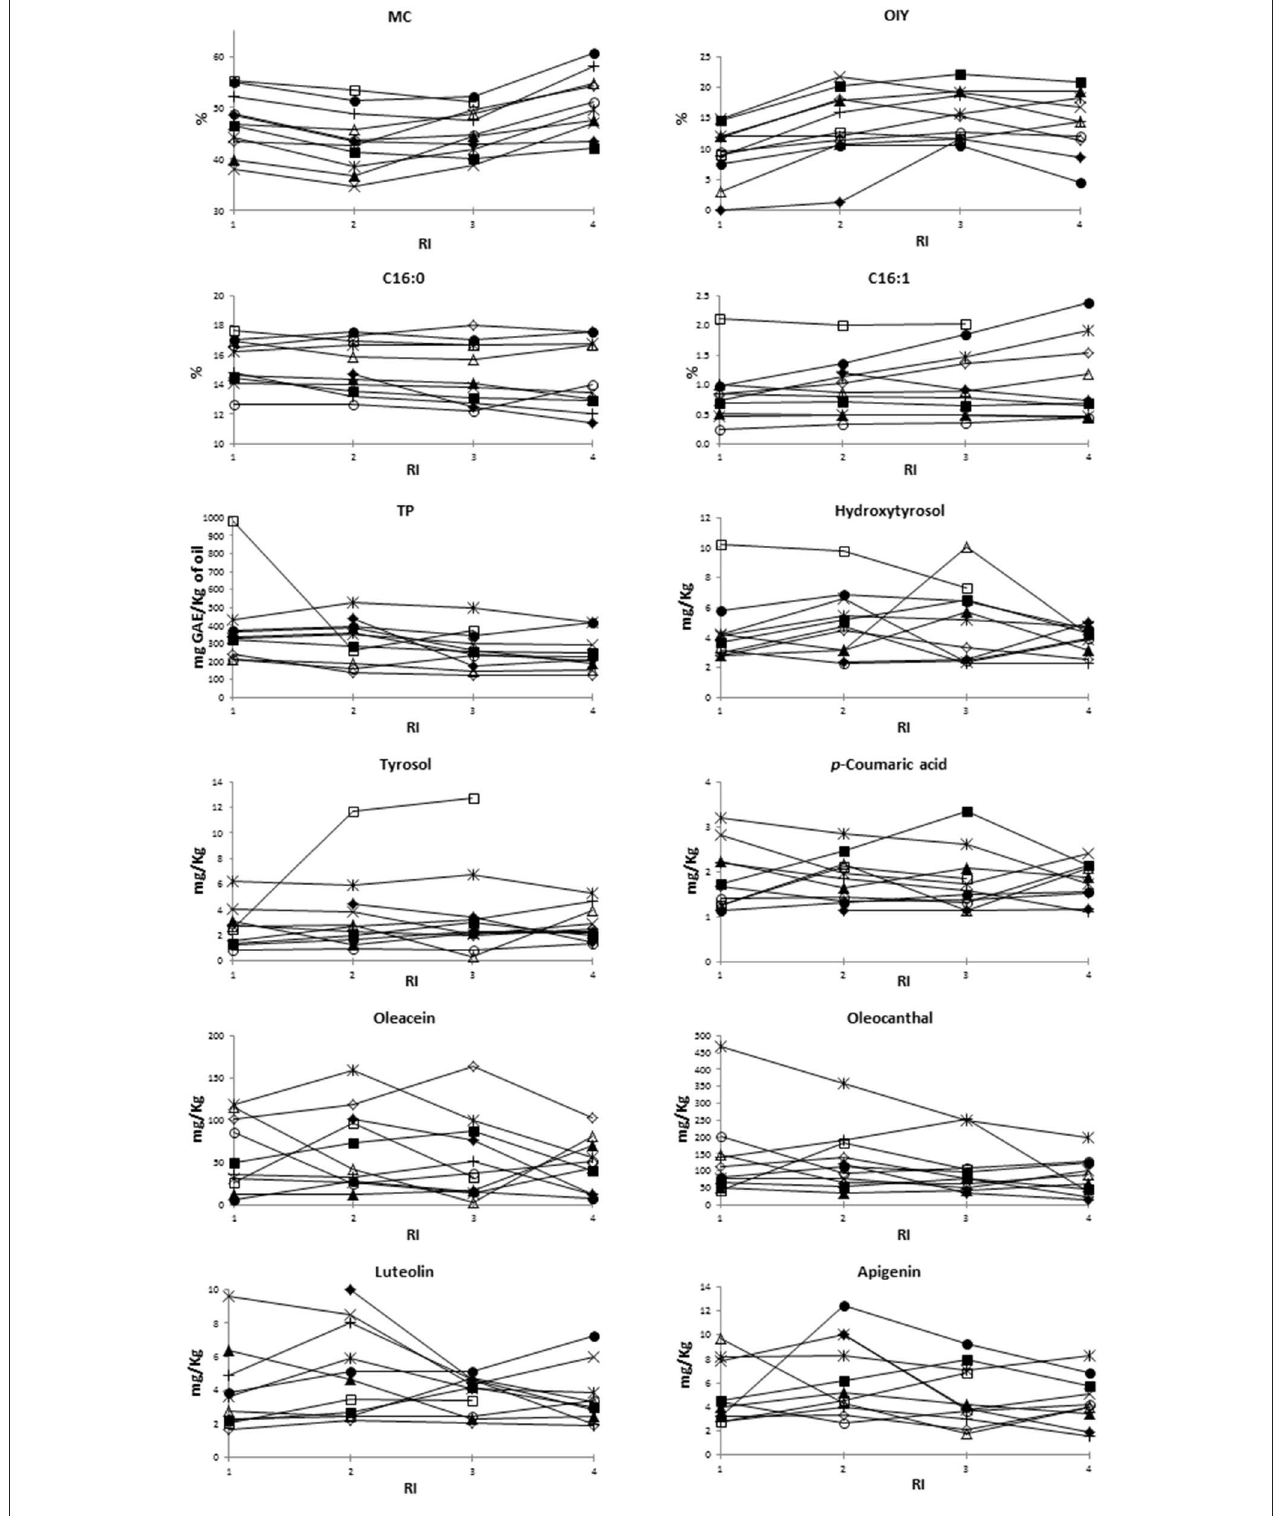
FIGURE 1 | Evolution pattern along ripening of the different studied traits. MC, moisture content; OIY, oil industrial yield; TP, total phenols; RI, ripening index. (cid:3) , “Ascolana Tenera;” × , “Baladi 1;” N , “Baladi 2;” ◦ , “Bella di Cerignola;” *, “Itrana;” • , “Jabaa;” + , “Kalamata;” △ , “Nabali;” ♦ ”, “Salonenque;” (cid:7) , “Sigoise;” (cid:4) , “Tanche”.